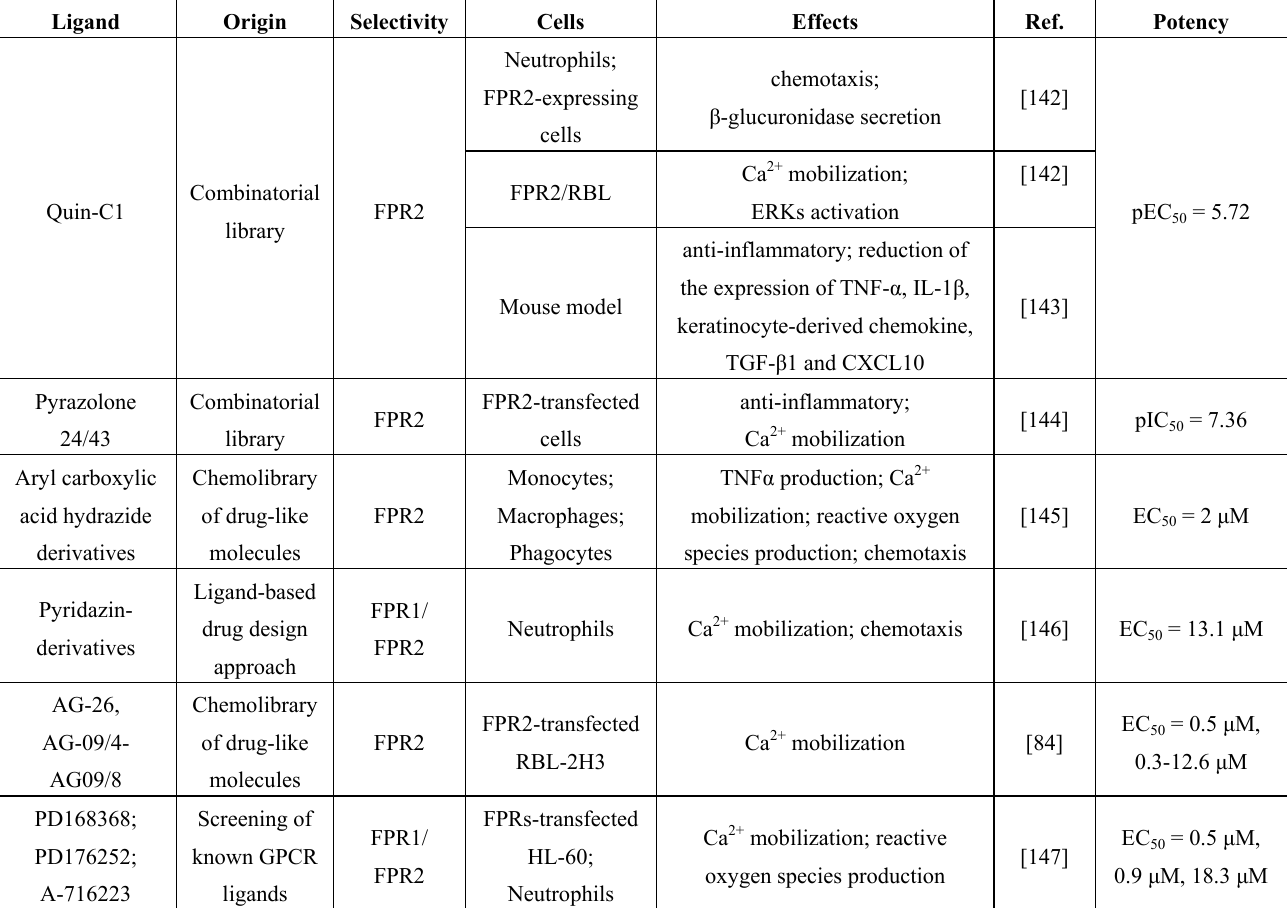
Table 10. Intracellular signaling cascades triggered by ligands from nonpeptide